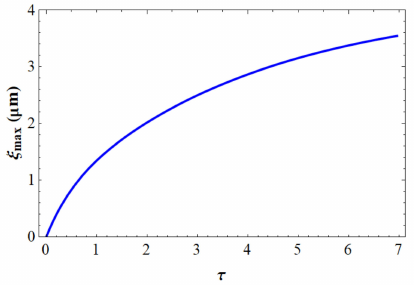
Figure 18. Transient behavior of ξ max (blue line).